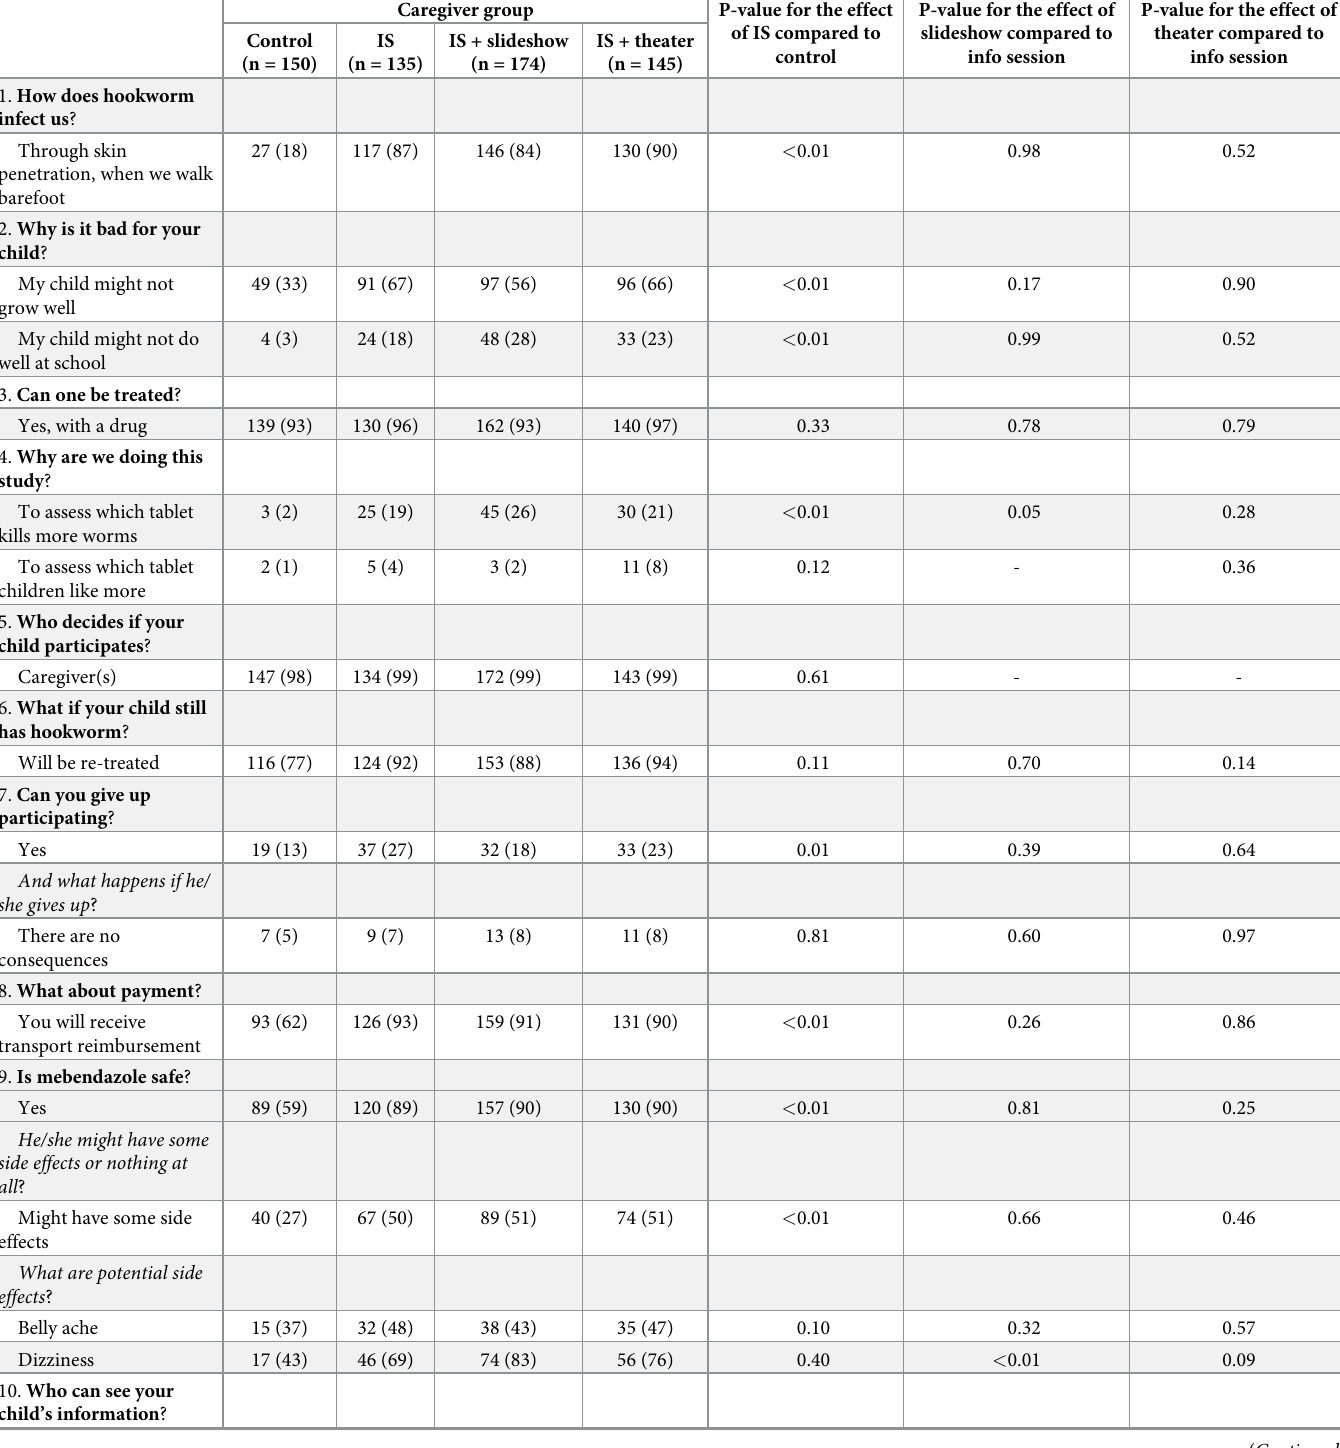
Table 2. Number of caregivers spontaneously answering each question correctly (Part A1). IS = information session. Data are n (%, using the total number of caregiv- ers in each group as a denominator).